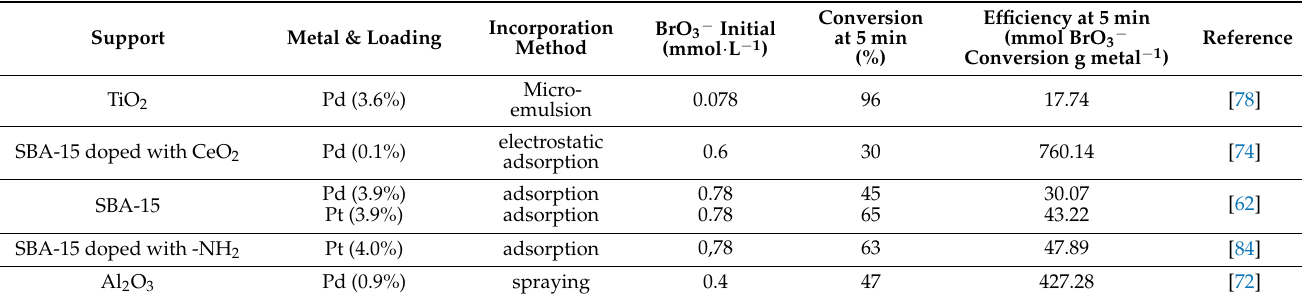
Table 1. Summary of the catalysts used for the bromate hydrogenation reaction at room temperature (22–27 °C) and atmospheric pressure using discontinuous reactors.